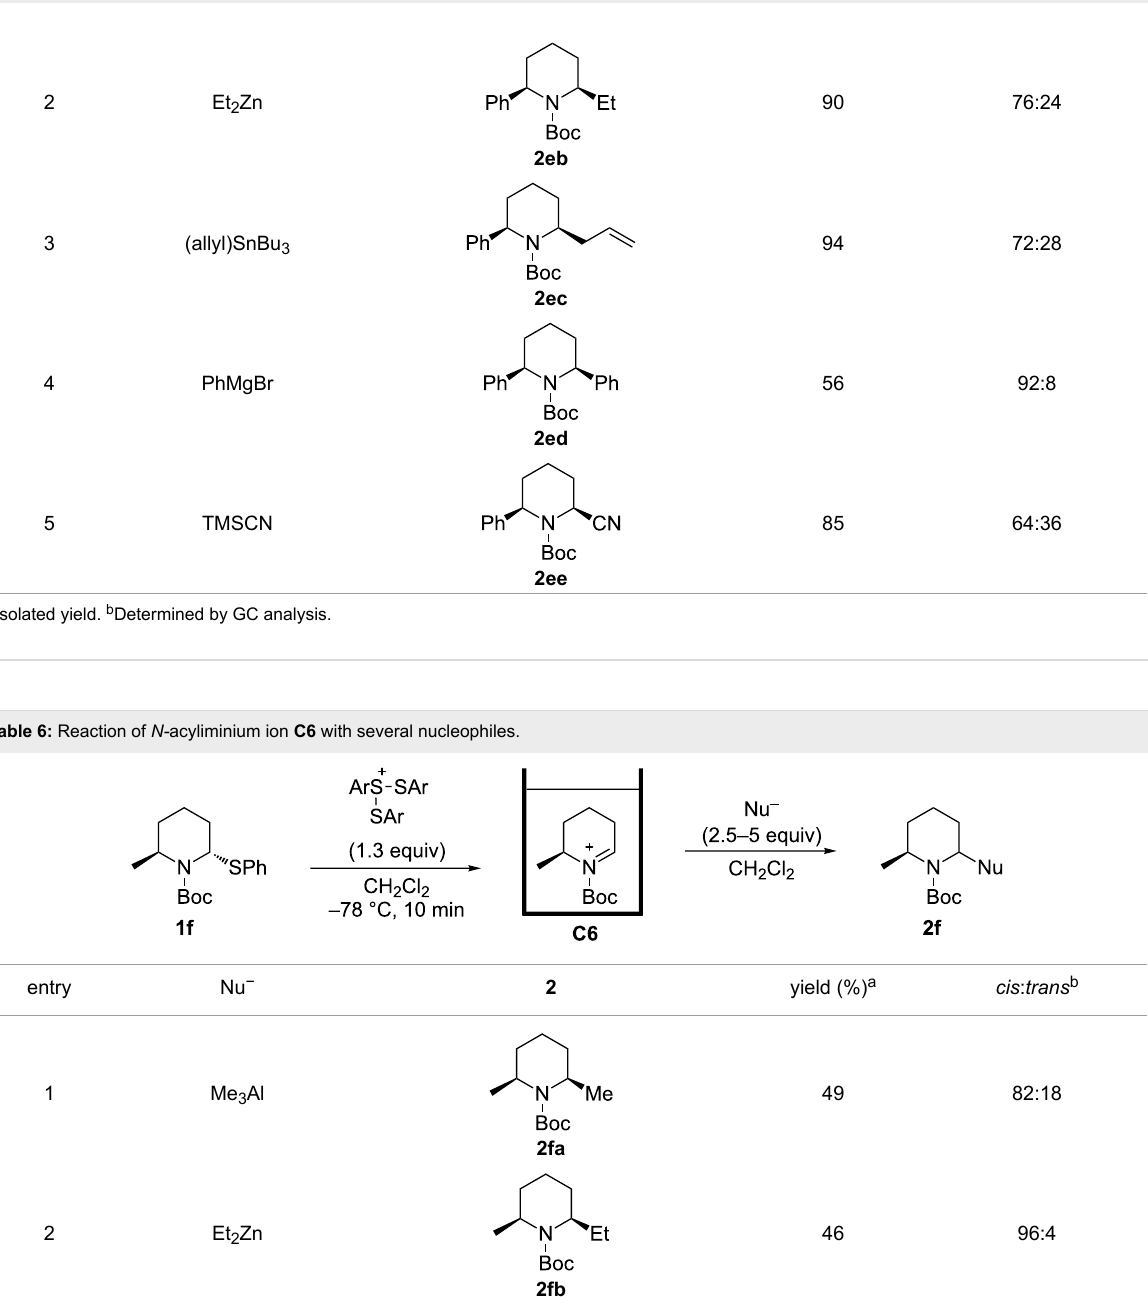
Table 5: Reaction of N- acyliminium ion C5 with several nucleophiles. (continued)